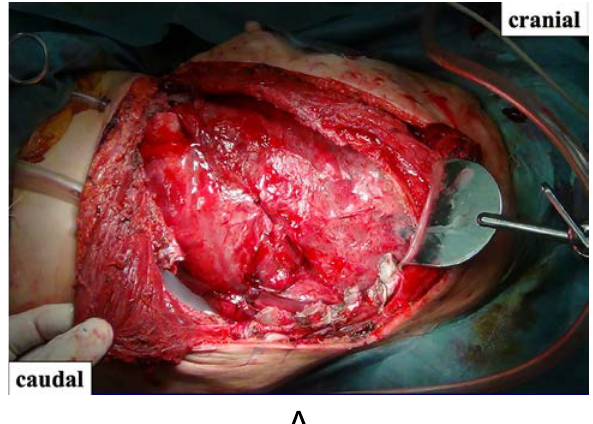
Figure 2 Computed tomography 3 months after the reconstruction showing good lung expansion with no atelectasis despite seroma formation. The yellow arrow indicates the